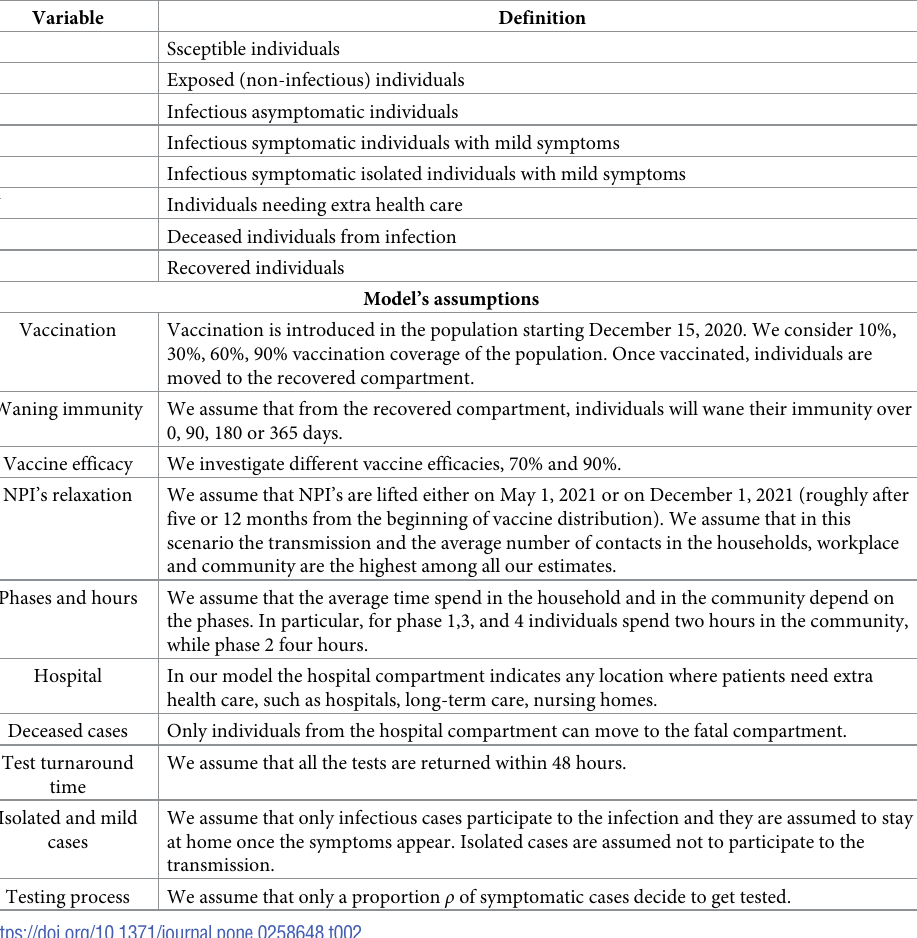
Table 2. Model variables and